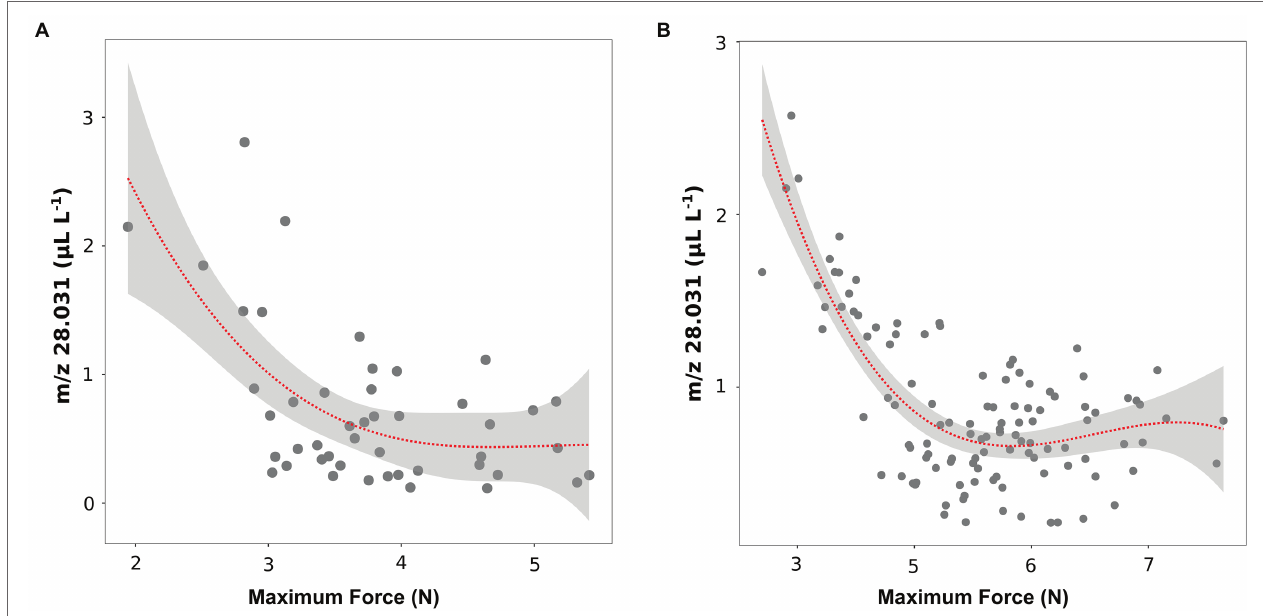
FIGURE 5 | Correlation plot and polynomial regression model between the ethylene content and the textural value of maximal force of 46 blueberry cultivars (A) and 124 accessions of a bi-parental full-sib population (B) both assessed after storage. Ethylene measurement was assessed on frozen powdered material by using an PTR/SRI-ToF-MS set in H 3 O + mode. Texture analysis was assessed on 10 berries by using a texture analyzer. Results of plot A were extrapolated from the raw data of Farneti et al. (2020).